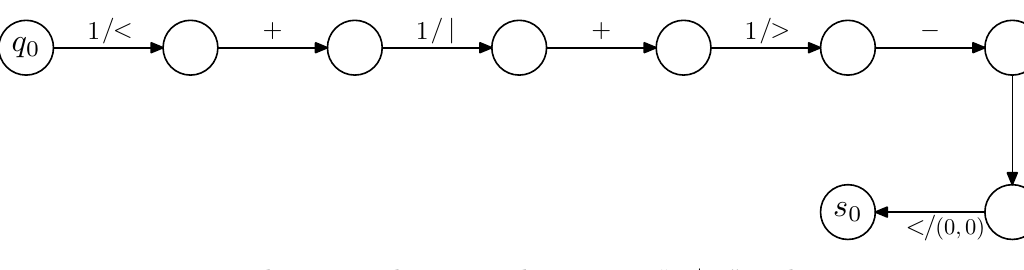
Fig. 2: The routine that writes the sequence “ < | > ” in the tape.